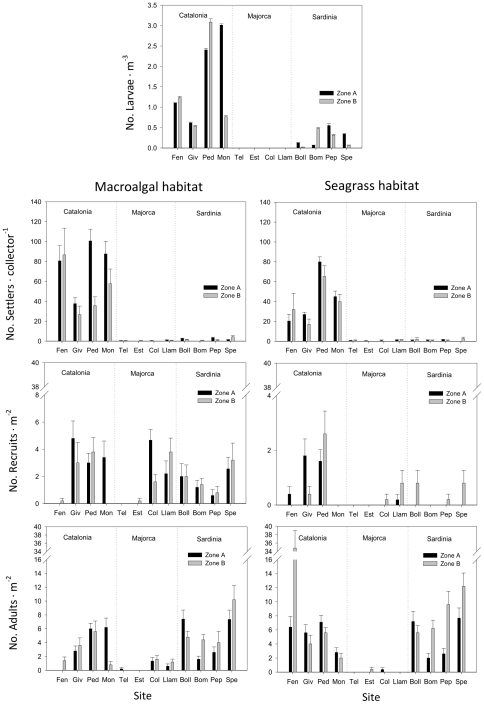
Abundance of sea urchin life-stages per habitat.Values show numbers of larvae (No. m−3), settlers (No. collector−1), recruits (sizes <3 cm; ind. m−2), and adult individuals (sizes >3 cm; ind. m−2) in rocky macroalgal and seagrass habitats at each spatial scale (region, site and zone). Site abbreviations as in Fig. 1.